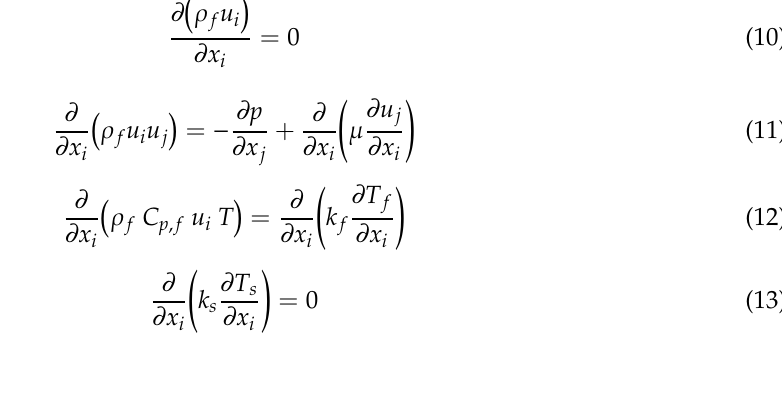
Figure 4. ( a ) The computational domain, and ( b ) the mesh for the plate-fin heat sink having 4 rows of